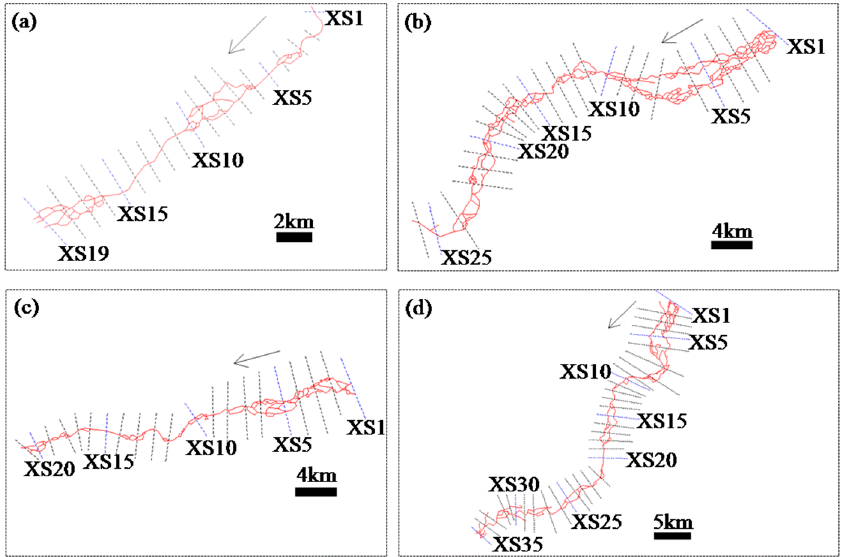
Figure 3. Simplified braided channels of the four reaches and the divided cross sections. The cross sections were named orderly from the first one in the upstream end (i.e., XS1) ( a ) RS1; ( b ) RS2; ( c ) RS3; ( d ) RS4.